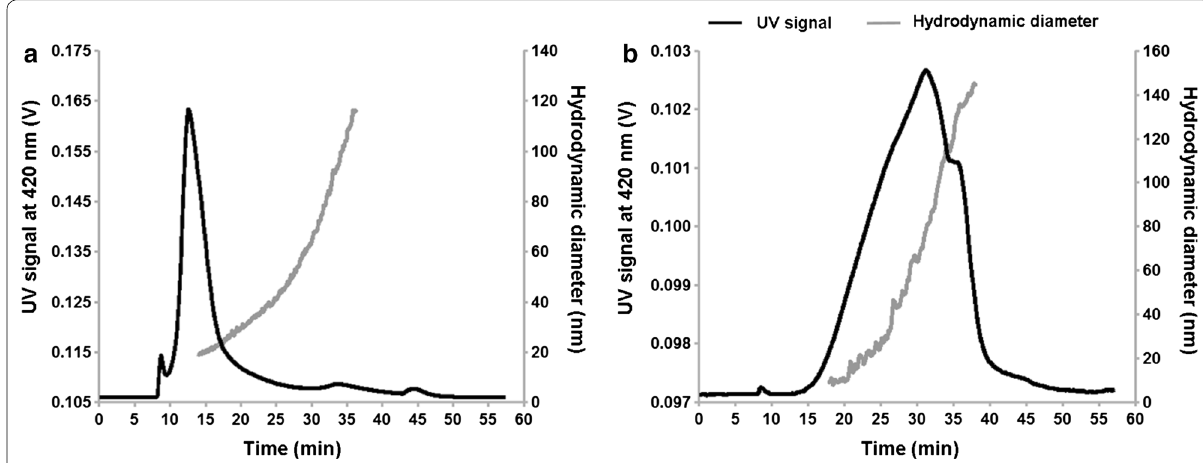
Fig. 1 AF4‑UV‑DLS measurements of Ag10‑COOH ( a ) and Ag10‑NH 2 ( b